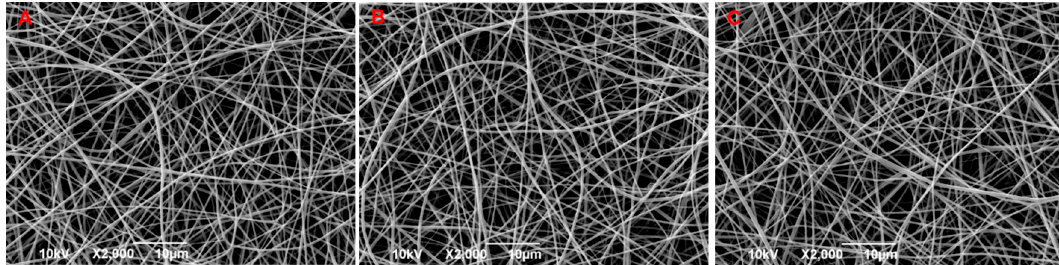
Figure A2. ( A – C ) Top-view SEM images of the PVP nanofibers loaded with ( A ) 1.2, ( B ) 30, and ( C ) 60 mg of ciprofloxacin respectively.